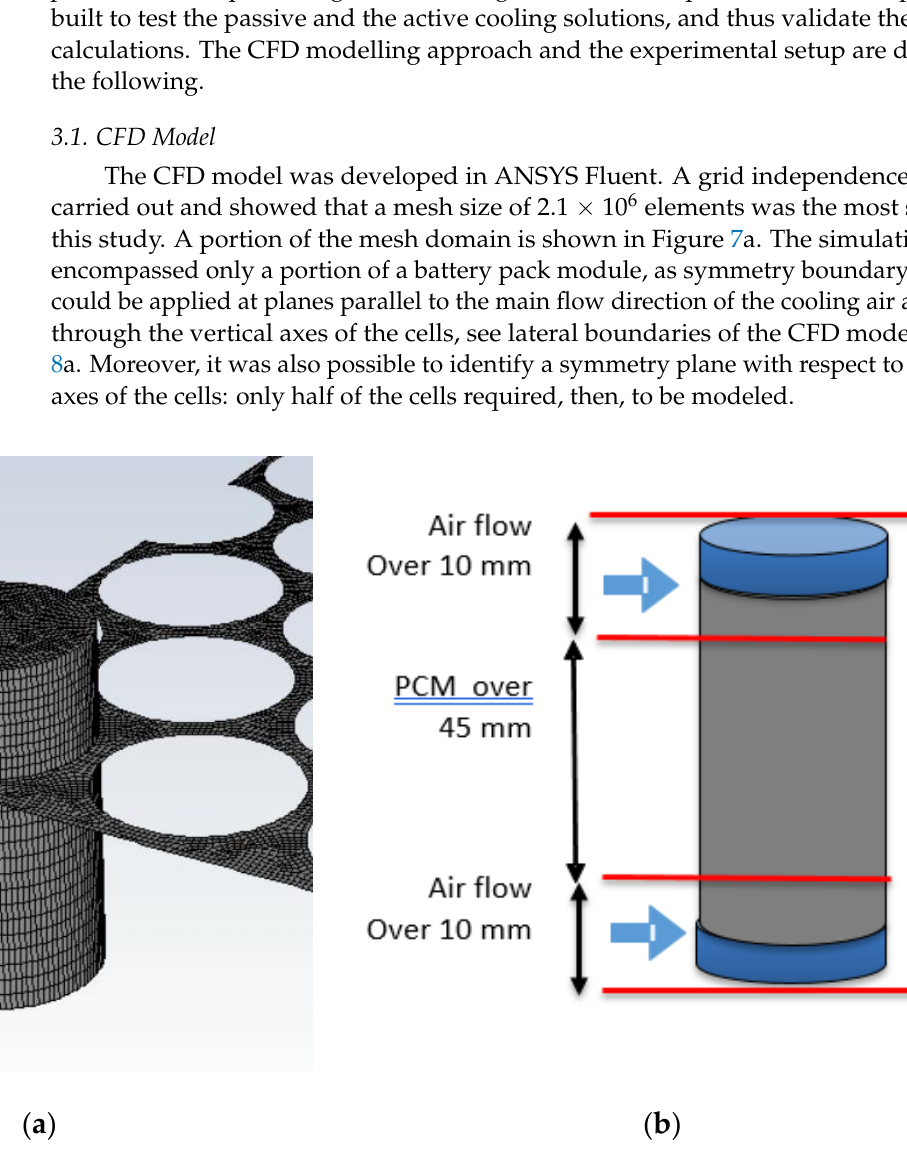
Figure 7. ( a ) Portion of the mesh domain of the CFD model, ( b ) simplified structure of the battery pack.